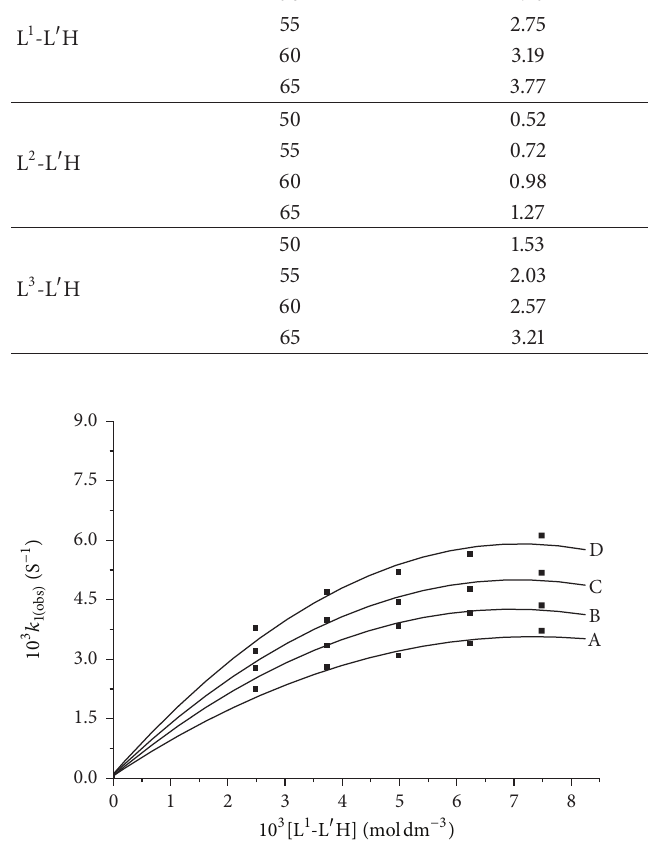
Figure 8: Plot of 1/𝑘 1( (s) versus 1/[ L 1 -L 󸀠 H ] , A = 50 , B = 55 , obs ) C = 60 , and D = 65 ∘